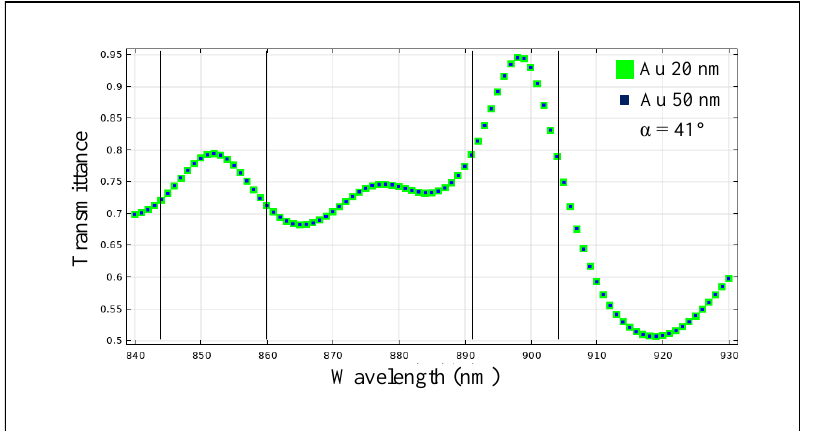
Figure 12. The transmittance diagram for the PhCs structure consisting of large GaAs nanorods and small Au nanorods with a deflection angle of